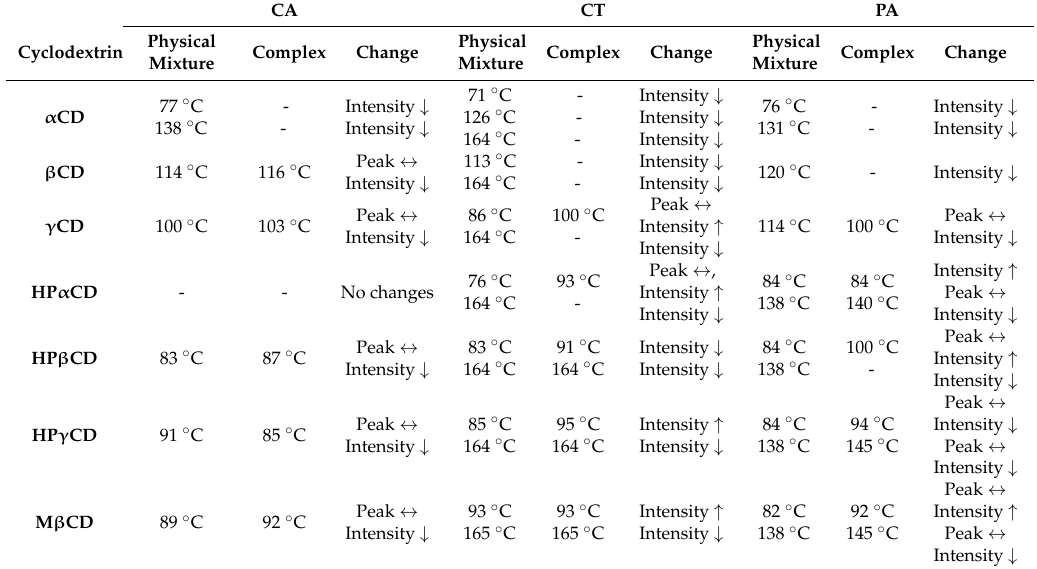
Table 1. Observed changes on the differential scanning calorimetry (DSC) thermograms of complexed samples, pure constituents, and physical mixtures. CA CT PA Physical Physical Physical Complex Cyclodextrin Complex Change Complex Change Mixture Mixture Mixture